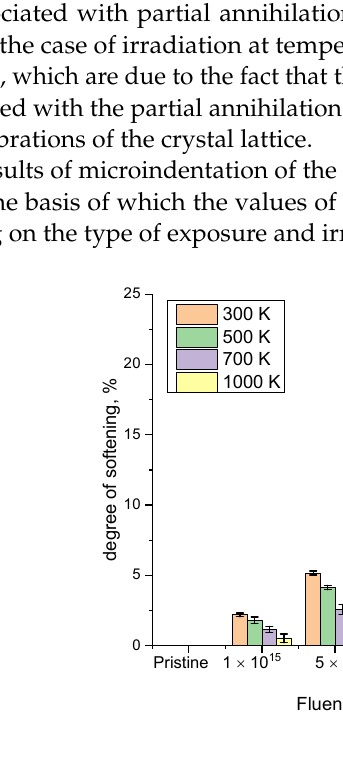
Figure 6. ( a ) Results of changes in the hardness of ceramics depending on the irradiation condi- tions; ( b ) Results of the change in the softening value at change of irradiation conditions. ( b ) Results of the change in the softening value at change of irradiation